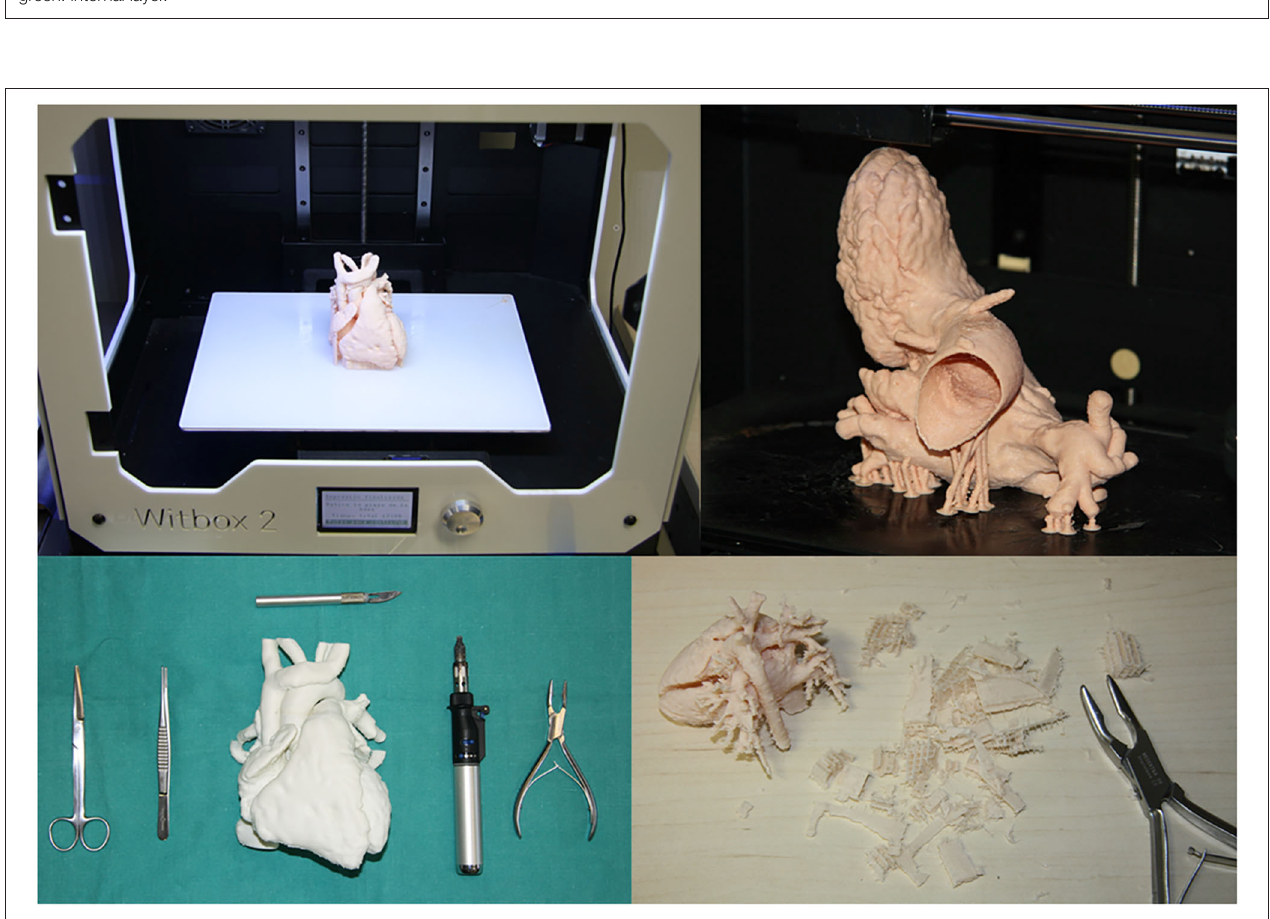
FIGURE 4 | 3D printing process and manual finishing operations. Heart model in BQ Witbox 2 printing plate (up left). Left heart model with supports (up right). Tools used for removing supports and repairing the model (scissors, tweezers, scalpel, gas blowtorch, and bone forceps).